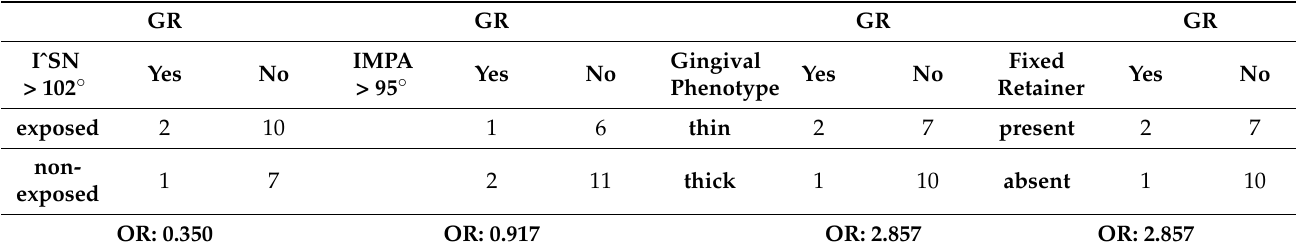
Table 4. Incisor inclinations, gingival phenotype, fixed retainer and GR.